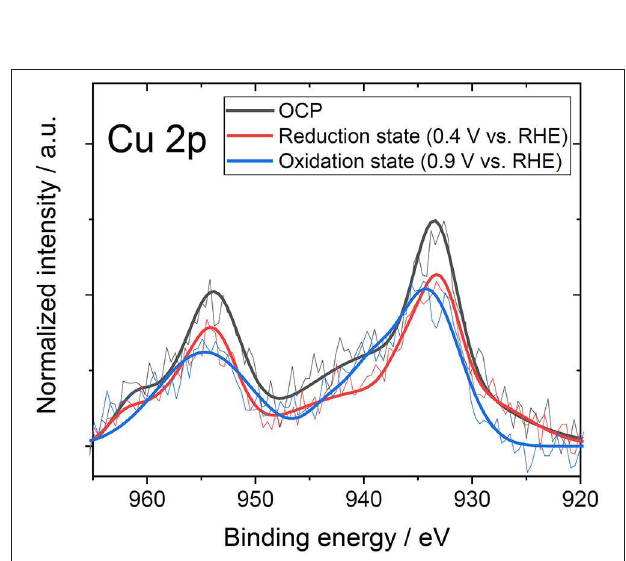
FIGURE 6 | XPS spectra of Cu 2p region for Cu-N-ZTCs being in different redox